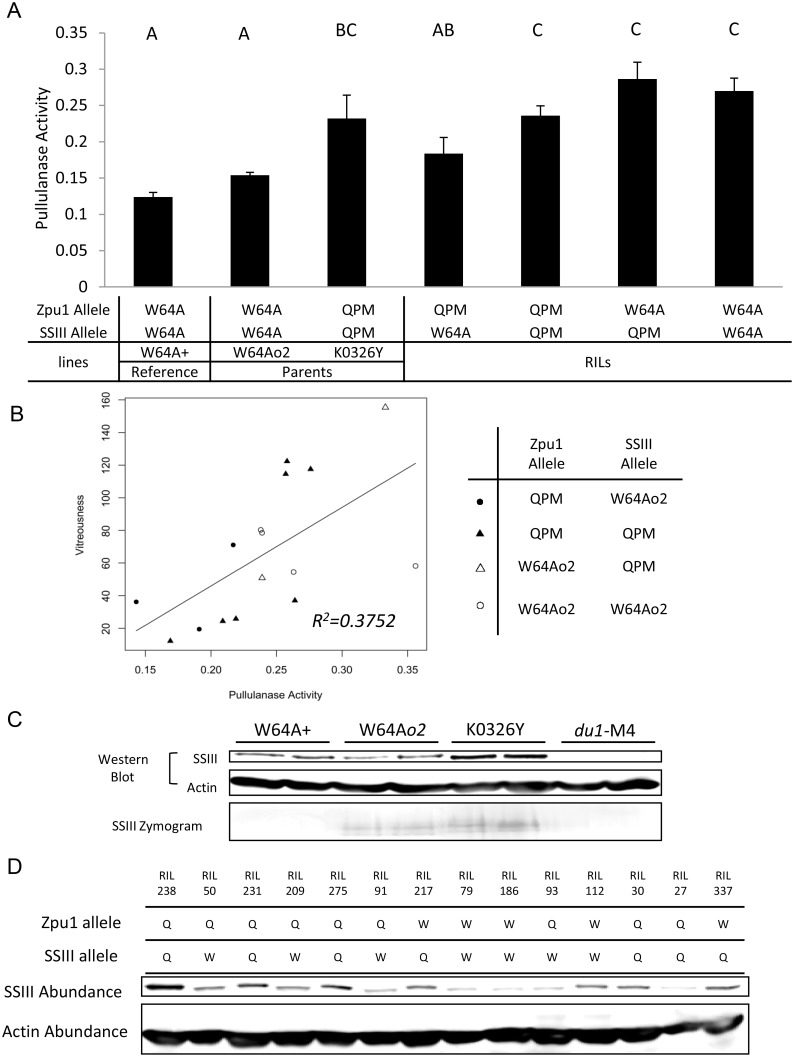
Pullulanase activity and SSIII abundance in parental lines and RILs.(A) Pullulanase activity of W64A+, W64Ao2,K0326Y and RILs with four Zpu1-SSIII genotypes. Pullulanase activity was measured by the spectrophotometer at 490 nm absorbance (y-axis). For the first three columns, each represents mean pullulanase activity of three independent ears of the corresponding lines; and for the remaining four columns, each represents mean pullulanase activity of all RILs with the corresponding genotype from three independent ears of each individual RIL. The letters above each column represent statistically significant differences among the lines with p<0.05 by pairwise two-tailed t-test. Columns with the same letter are not significantly different from one another. The error bars represent standard error. (B) Positive correlation between pullulanase activity and kernel vitreousness. The significance level of the correlation was tested by ANOVA of the slope at p<0.05. Each data point represents mean pullulanase activity of three independent ears of each individual RIL. (C) SSIII abundance and SSIII activity of W64A+, W64Ao2, K0326Y and du1M4. SSIII abundance was tested by SDS-PAGE followed by Western blot (Images of the whole blots and SDS-PAGE gels are provided in S4 and S6 Figs). SSIII activity was tested by native PAGE followed by a zymogram for the RILs. (Image of whole zymogram gel is provided in S4 Fig) (D) Western blot of SSIII among RILs homologous for W64Ao2 (W) or QPM (Q)–derived Zpu1 or SSIII alleles. The order of samples corresponded to their kernel vitreousness, from most opaque to most vitreous (left to right; images of whole blots and SDS-PAGE gels are provided in S5 and S7 Figs).